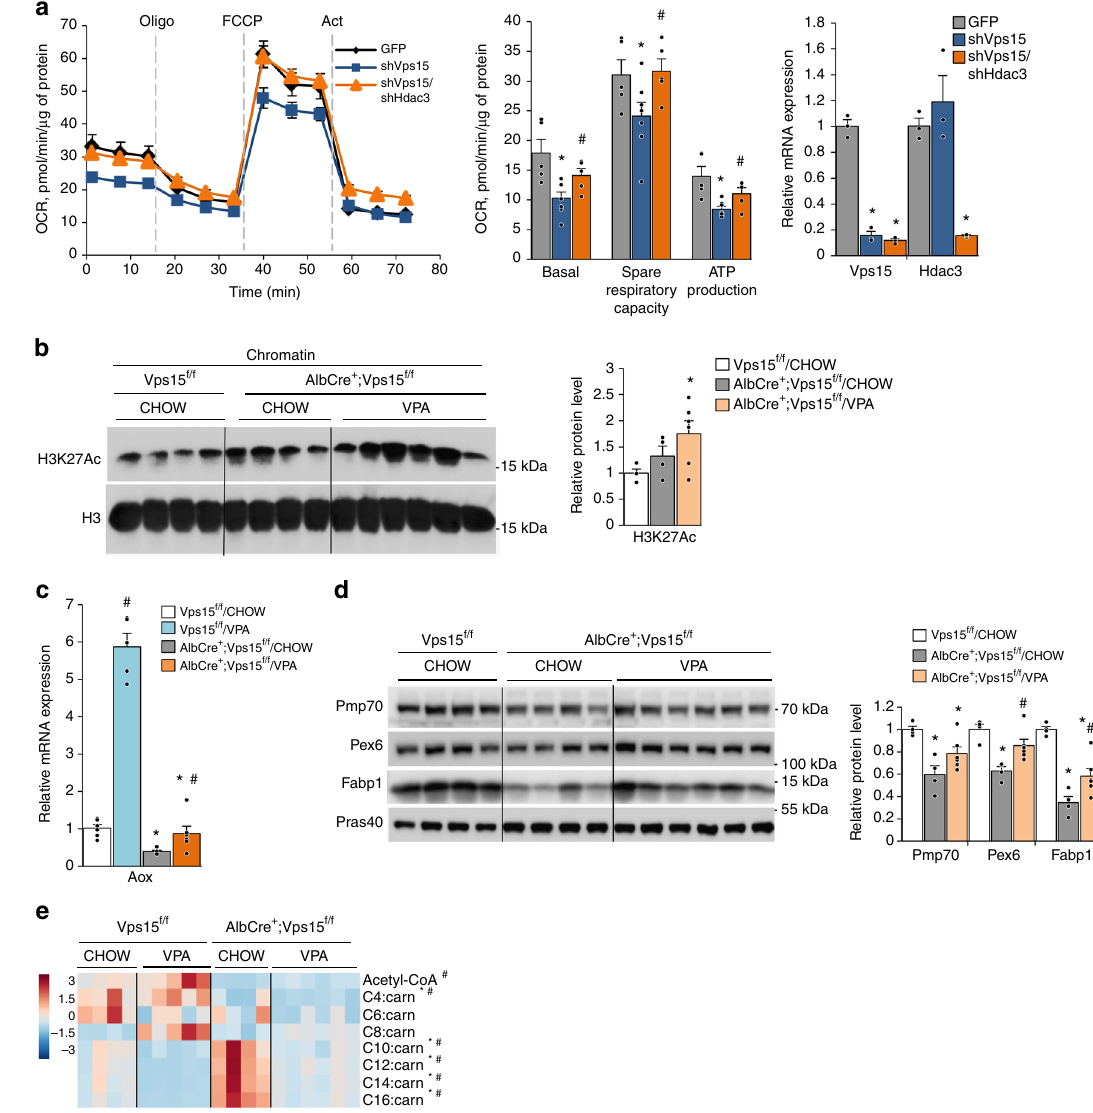
Fig. 5 Inhibition of Hdac3 improves PPAR α responses in livers of Vps15-LKO mice. a The OCR measured by SeaHorse Bioanalyzer in primary hepatocytes 48 h post-transduction with adenoviral vectors expressing GFP, shRNAVps15 or shRNAVps15 + shRNAHdac3 under basal conditions and in response to sequential treatment with indicated reagents. Dashed lines indicate the time of the addition of each reagent. Representative experiment of three independent hepatocyte cultures is presented. Quanti fi cation of basal respiration, ATP production and maximal respiratory capacity are shown on the graphs (middle panel). Relative transcript levels of Vps15 and Hdac3 is shown on right panel. Data are means ± SEM ( n = 3, P < 0.05 *: vs GFP-infected cells, #: vs shRNAVps15-infected cells, two-tailed, unpaired Student ’ s t test). b Immunoblot analysis of chromatin extracts from the liver tissue of six week old random-fed Vps15 f/f and AlbCre + ;Vps15 f/f mice that were treated for two weeks with VPA incorporated in food or control chow food. Densitometric analyses of H3K27Ac levels normalised to total H3 levels presented as folds over Vps15 f/f -chow condition. Data are means ± SEM ( n = 4 for Vps15 f/f and AlbCre + ;Vps15 f/f chow, n = 6 AlbCre + ;Vps15 f/f VPA, P < 0.05 *: vs Vps15 f/f , #: vs chow, two-tailed, unpaired Student ’ s t test). c Relative mRNA expression levels of Aox in the livers of mice treated as in b . Data are means± SEM ( n = 6 for Vps15 f/f and AlbCre + ;Vps15 f/f chow, n = 5 Vps15 f/f VPA, n = 6 AlbCre + ; Vps15 f/f VPA, P < 0.05 *: vs Vps15 f/f , #: vs chow, two-tailed, unpaired Student ’ s t test). d Immunoblot analysis of total protein liver extracts of mice treated as in b using indicated antibodies. Densitometric analyses of protein levels normalised to Pras40 levels presented as folds over Vps15 f/f -chow condition. Data are means ± SEM ( n = 4 for Vps15 f/f and AlbCre + ;Vps15 f/f chow, n = 6 AlbCre + ;Vps15 f/f VPA, P < 0.05 *: vs Vps15 f/f , #: vs chow, two-tailed, unpaired Student ’ s t test). e Heat map showing relative levels of Acetyl-CoA and Acyl-carnitine metabolites measured by mass spectrometry in the livers of mice treated as in b . Each column corresponds to an individual animal and the colour of the cell indicates the relative content of the metabolite (from blue to red). Data are means ± SEM ( n = 4 for Vps15 f/f and AlbCre + ;Vps15 f/f chow, n = 5 Vps15 f/f VPA, n = 6 AlbCre + ;Vps15 f/f VPA, P < 0.05 *: AlbCre +